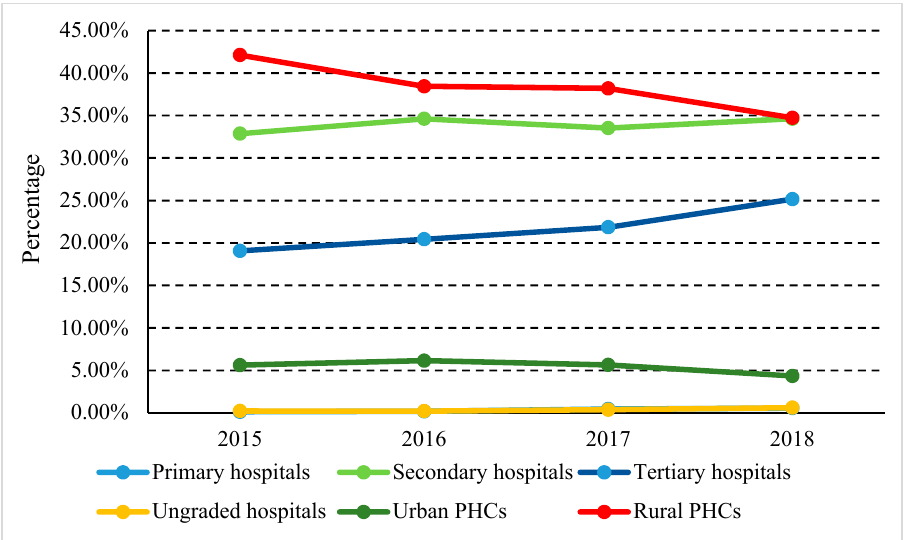
Figure 3. Proportional consumption (%) of parenteral antibiotics used in healthcare institutions in Shaanxi Province, western China, 2015–2018.